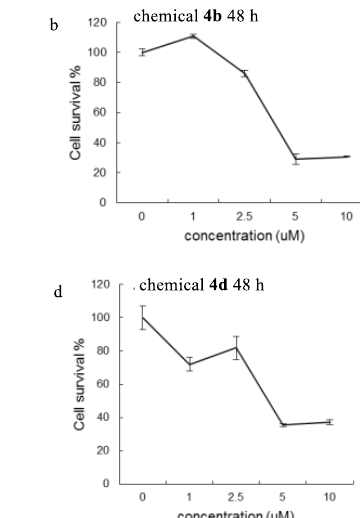
Figure 1. Synthesized chemicals inhibit LNCaP cell survival in a dose-dependent manner. LNCaP cells were treated for 48 h with chemicals at different concentrations and analyzed via WST-1 cell growth assay: ( a ) chemical 4a ; ( b ) chemical 4b ; ( c ) chemical 4c ; ( d ) chemical 4d .